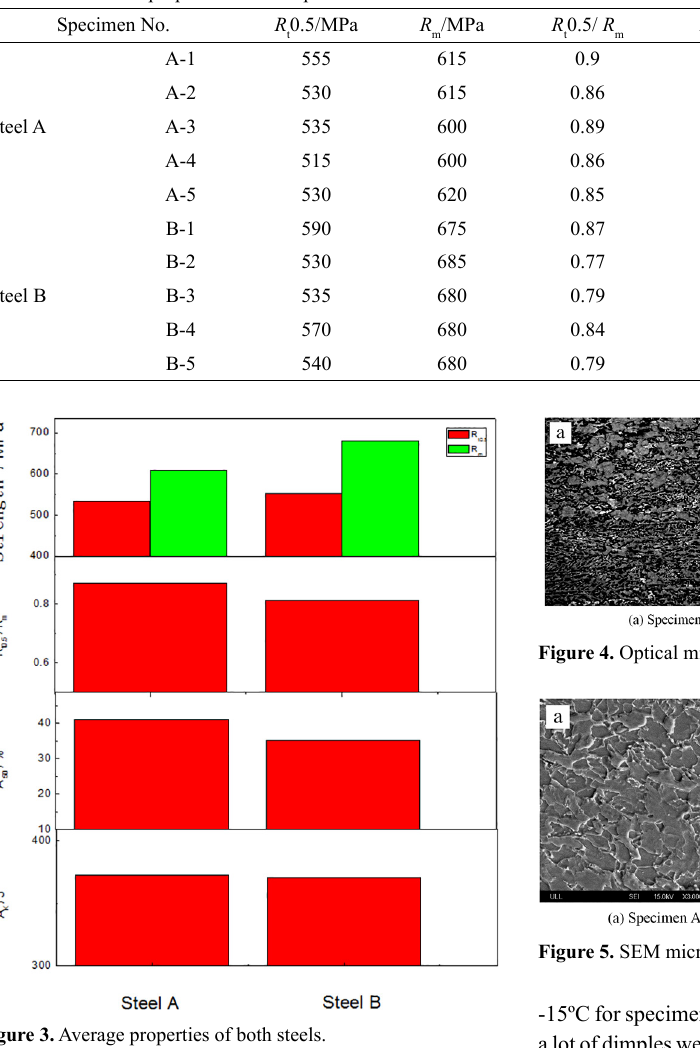
Figure 3. Average properties of both steels.